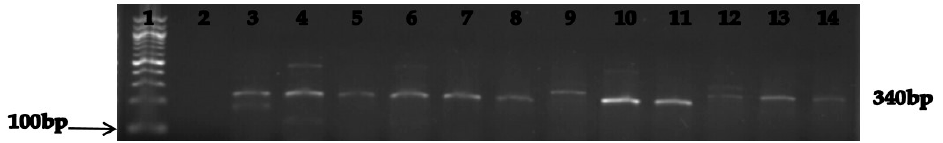
Figure 5. PCR products of the amplification of bla NDM-1 gene. Lane1: 100 bp molecular weight marker; Lane 2: negative control; Lanes 3–14: positive isolates.